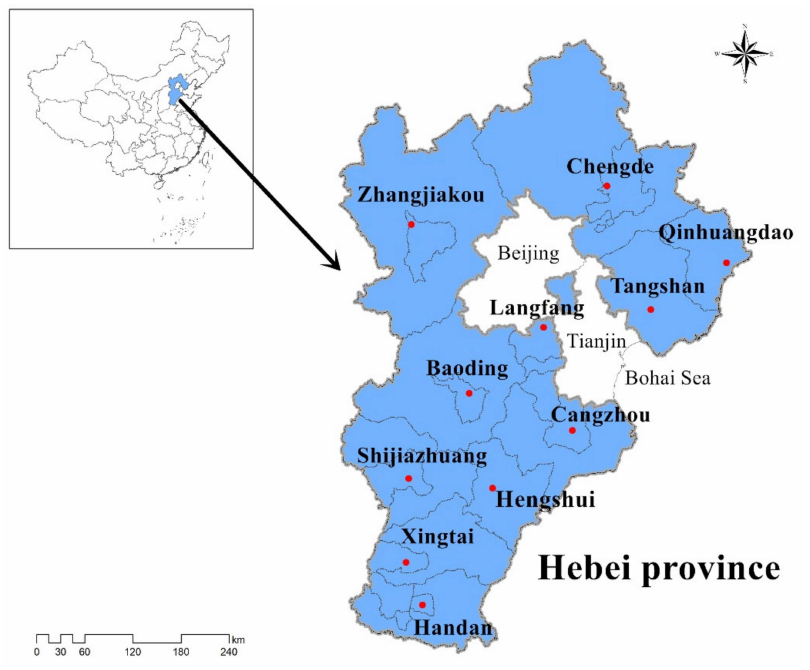
Figure 2. Location of Hebei,